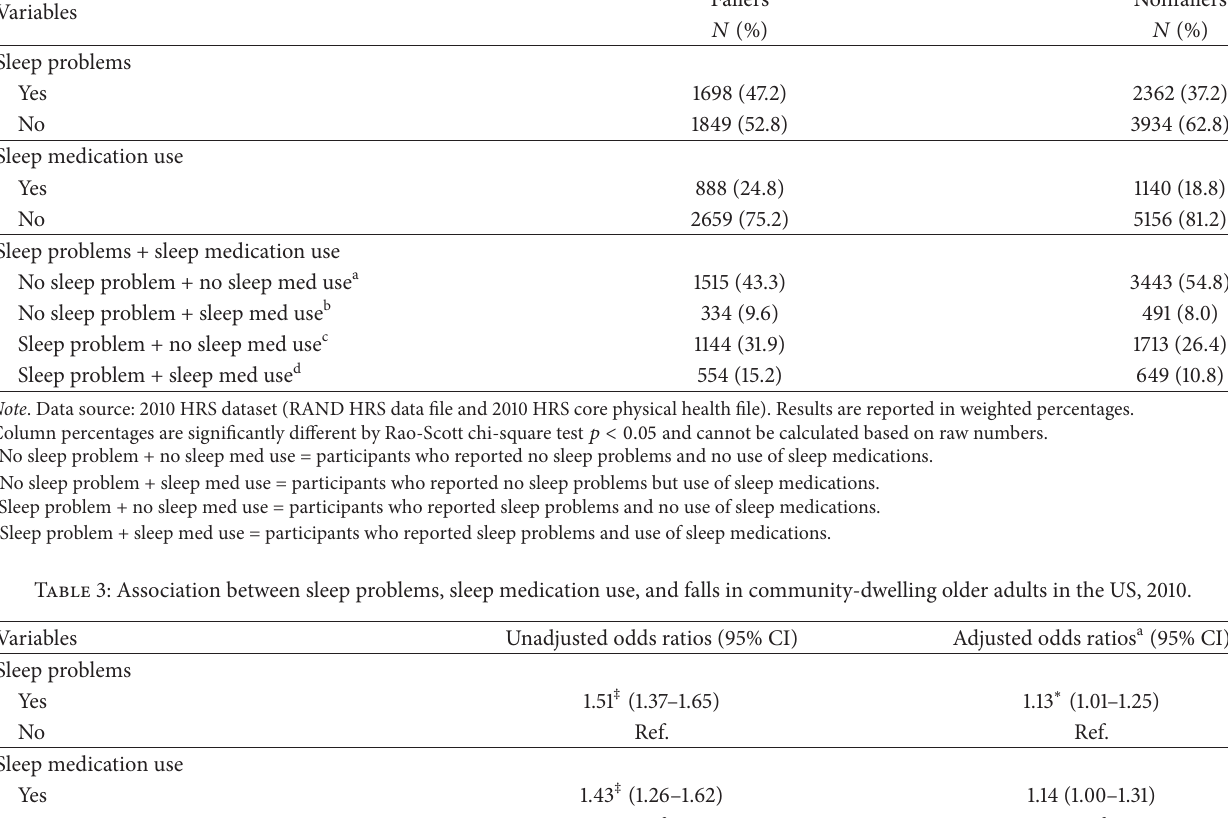
Table 2: Distribution of predictor variables against falls in community-dwelling older adults in the US, 2010. Variables